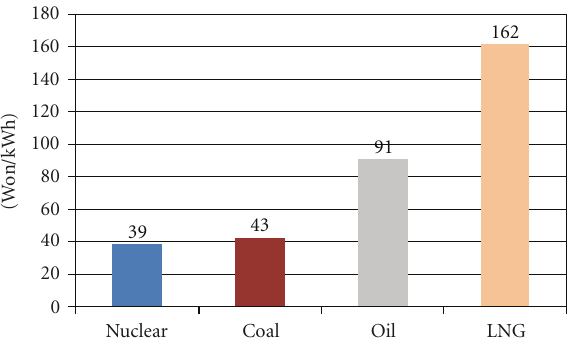
Figure 27: Emission quantities from di ff erent energy sources.